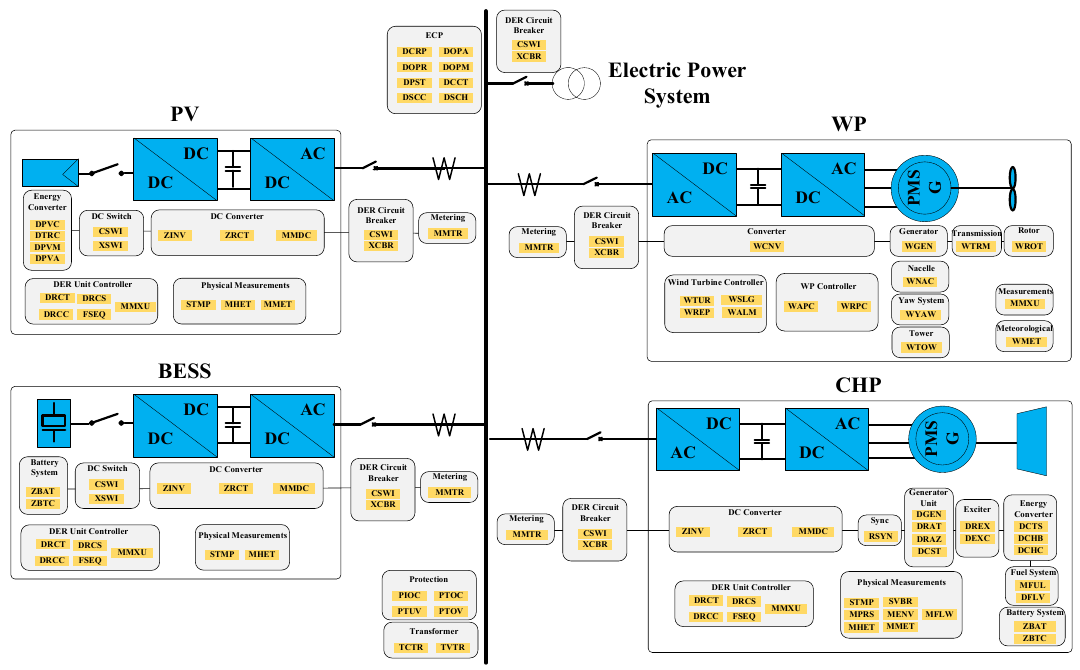
Figure 3. Conceptual organization of micro-grid